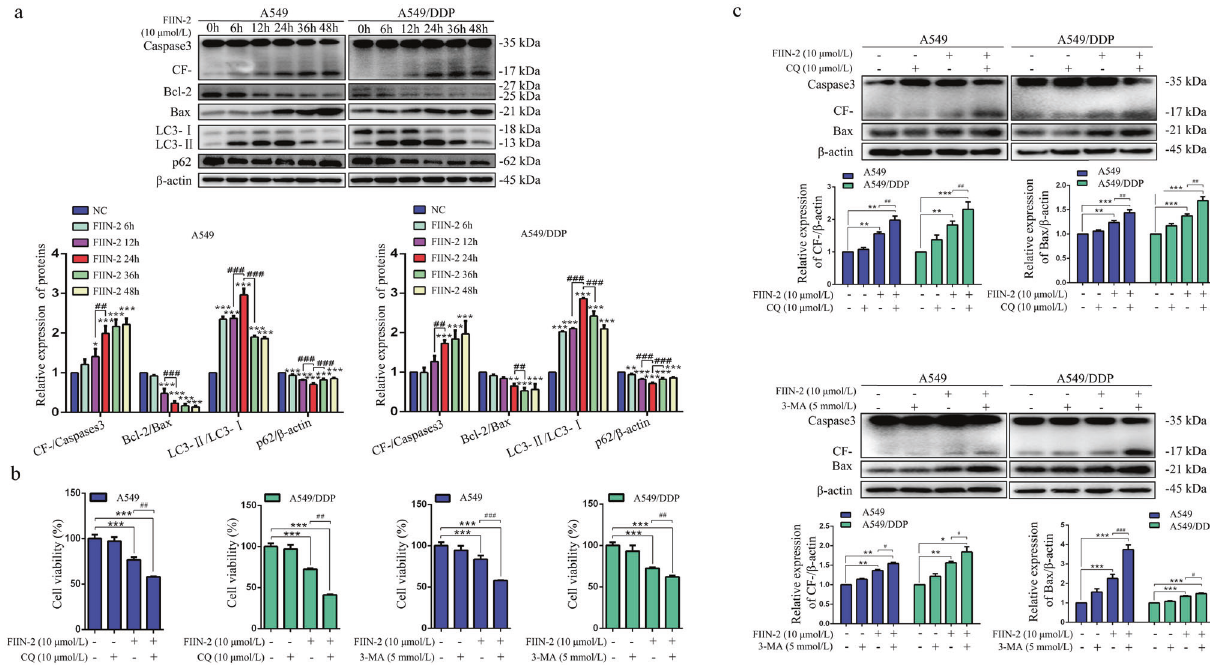
Fig. 5 Inhibition of autophagy enhanced FIIN-2-mediated cytotoxicity in A549 and A549/DDP cells. a Cells were treated with FIIN-2 (10 μ mol/L) for 48 h, and the levels of Bcl-2, Bax, cleaved Caspase-3, LC3, and p62 at different times were detected by western blot analysis. Cells were treated with FIIN-2 (10 μ mol/L), CQ (10 μ mol/L), or 3-MA (5 mmol/L) alone and FIIN-2 combined with CQ/3-MA for 24 h. b Cell viability was detected by CCK-8 assay. c The expression of Bax and cleaved Caspase-3 was detected by western blot analysis. β -actin was used as a loading control. Each bar corresponds to the mean ± SD of three independent experiments. * p < 0.05, ** p < 0.01, *** p < 0.001; # p < 0.05, ## p < 0.01, ### p < 0.001. CF-, cleaved